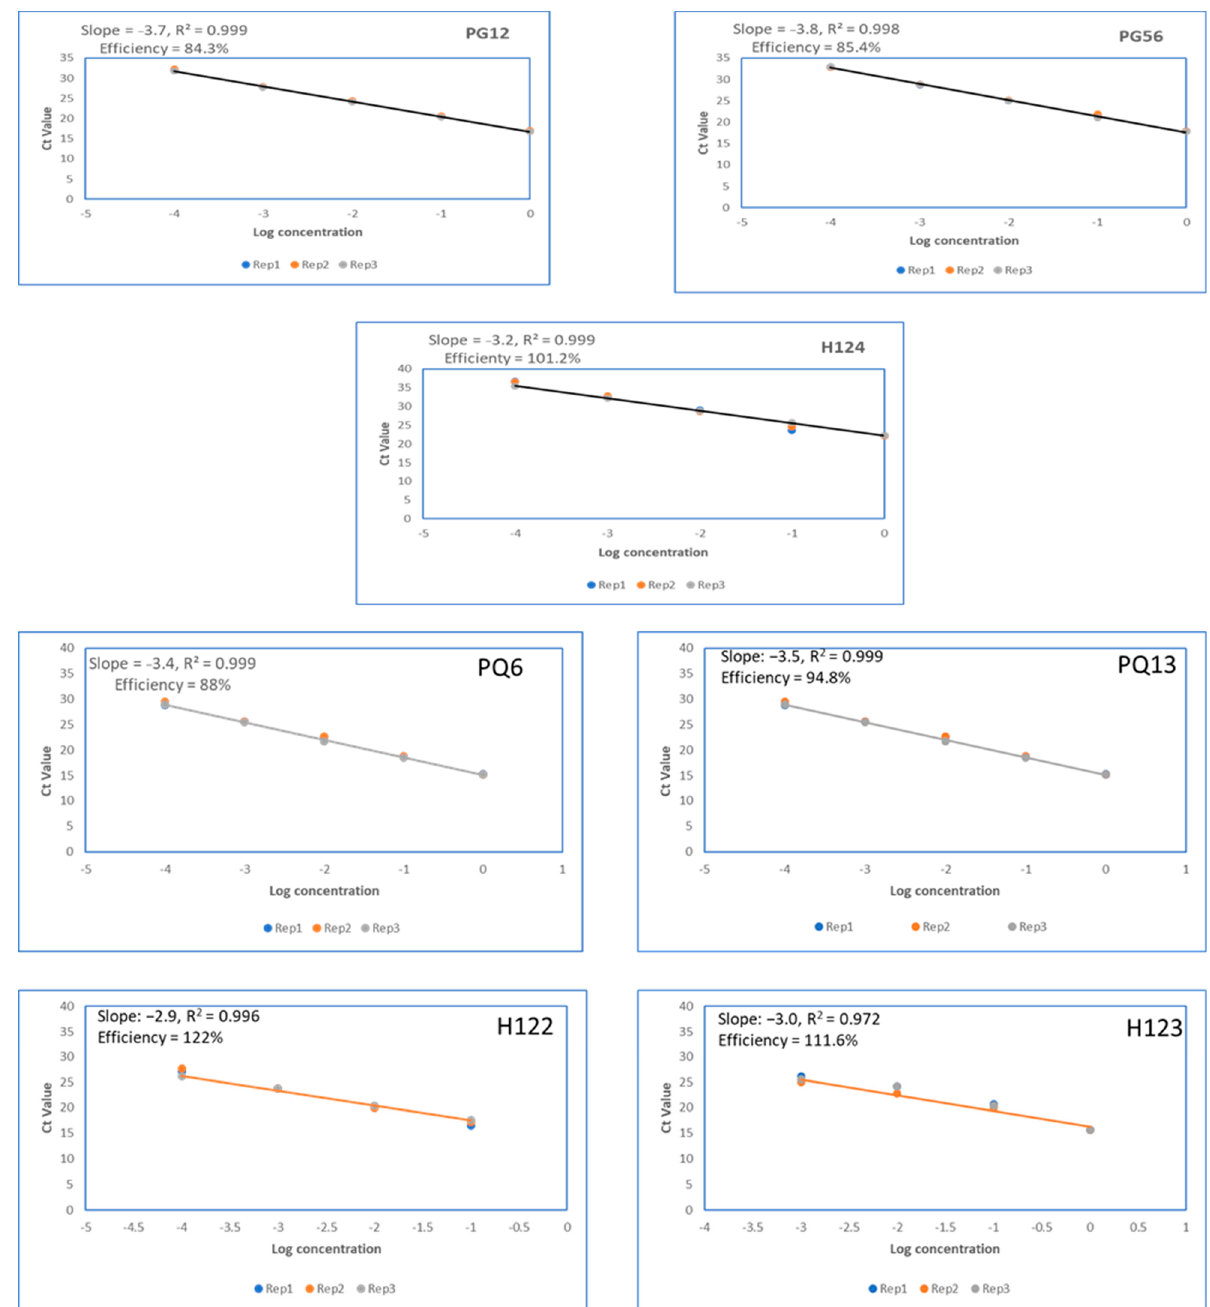
Figure 2. Amplification efficiency of Panax ginseng (PG12, PG56, and H124), and Panax quinquefolius (PQ6, PQ13, H122, and H123) assays show industrially processed samples (H122, H123, and H124) have efficiency values above 100% and reference samples (PG12, PG56, PQ6, and PQ13) have efficiency values below 100%.